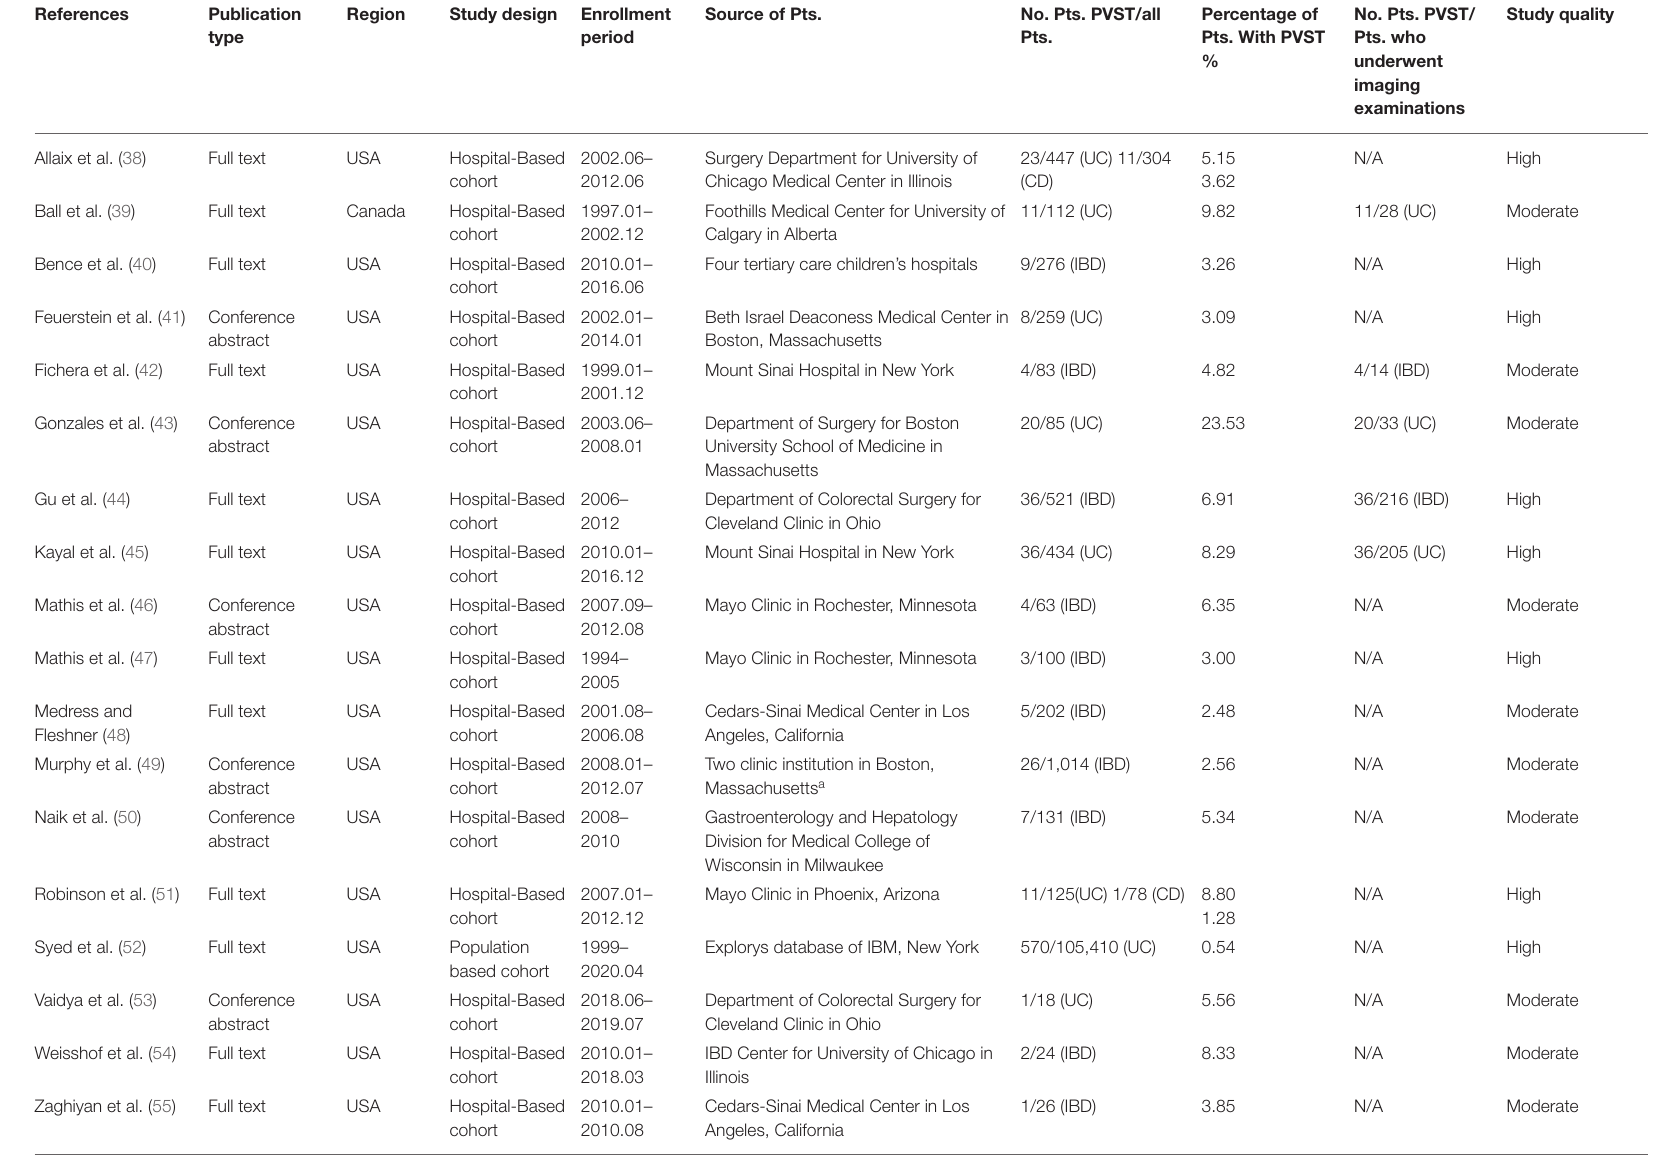
TABLE 3 | Characteristics of studies where all the included patients underwent colorectal